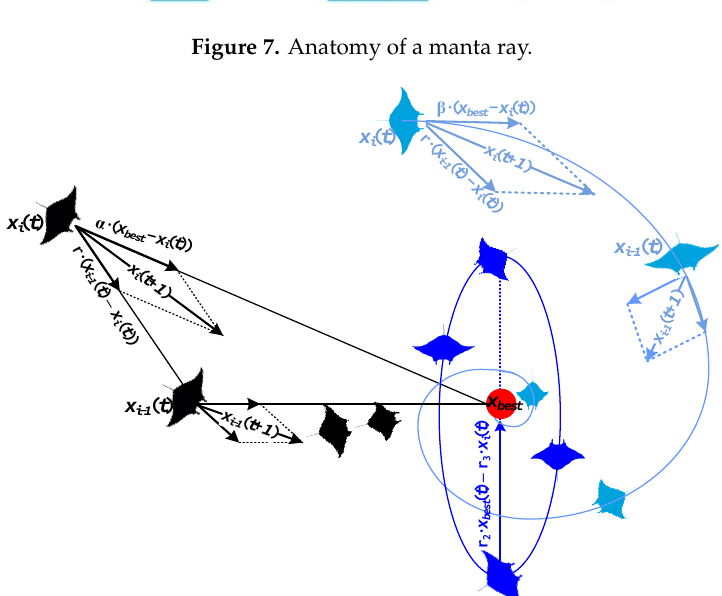
Figure 8. Foraging behaviors of manta rays (black: chain foraging; light blue: cyclone foraging; blue: somersault foraging); red: plankton in high concentration.